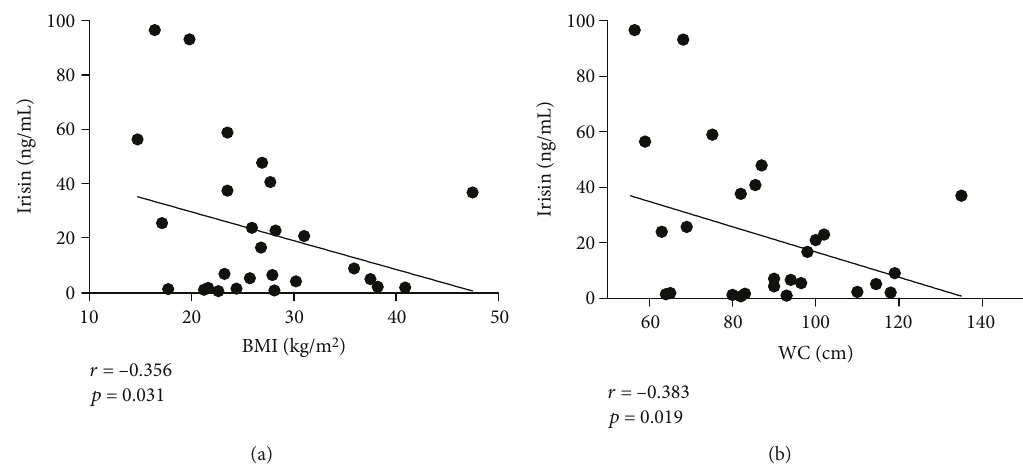
Figure 2: Correlation between irisin plasma levels and anthropometric parameters. Association of plasma irisin levels with BMI (a) and waist circumference (b). BMI=body mass index; WC=waist circumference.